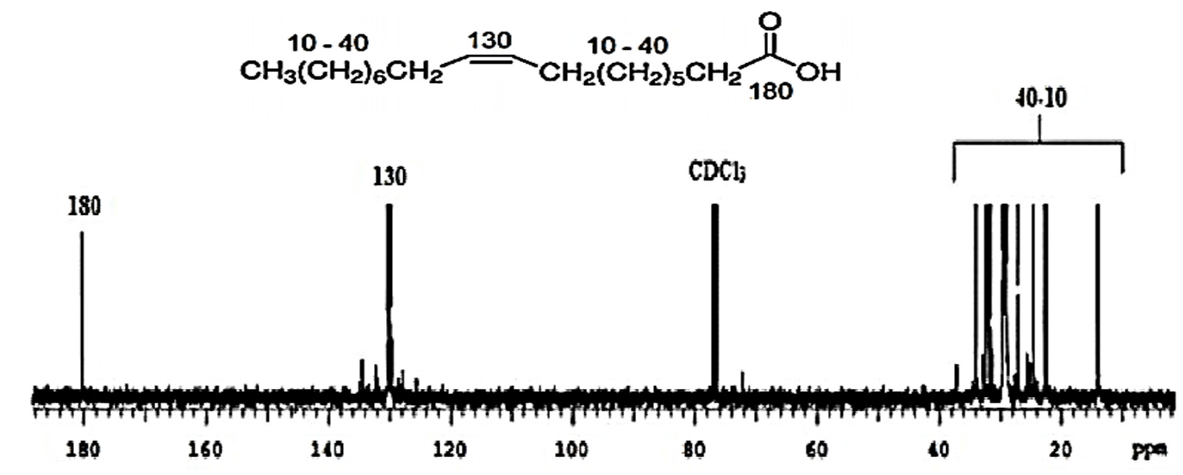
Figure 3. 1 H NMR spectrum (CD 3 OD, 300 MHz) of the isolated biosurfactant of Candida sphaerica cultivated in medium supplemented with 9% vegetable oil refinery residue and 9% corn steep liquor.